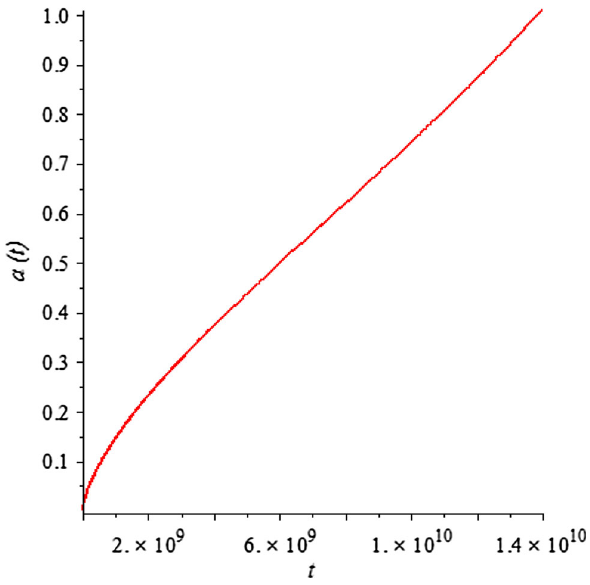
Fig. 1 Qualitativebehaviourofthescalefactor a ∝ sinh 2 3 t isapparent in a versus t plot. Therefore at early epoch, the scale factor evolves as t 2 3 , confirming early deceleration and late-time acceleration